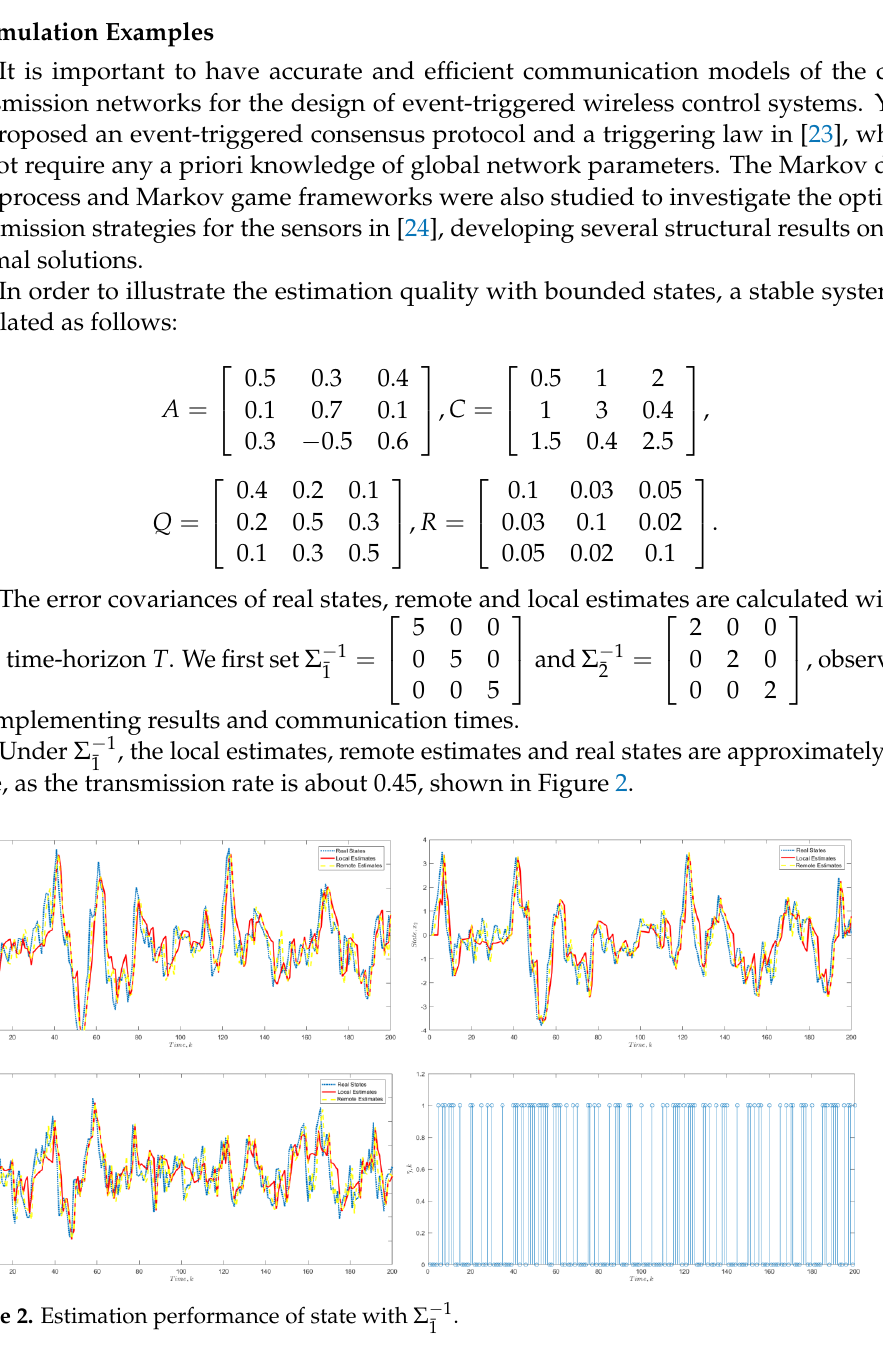
Under Σ − 1 , the transmission rate is improved to about 0.55, shown in Figure 3, ¯2 changing between 0.4 and 0.6